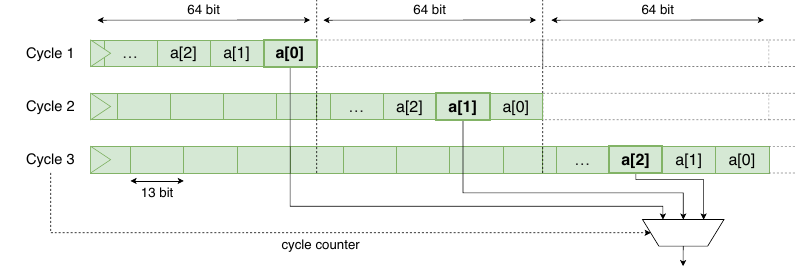
Figure 5: Buffer loading of polynomial data for the first three cycles. Each row represents the buffer at different cycles, and green indicates the polynomial data that has been loaded. of a polynomial multiplication is represented in Fig. 6.